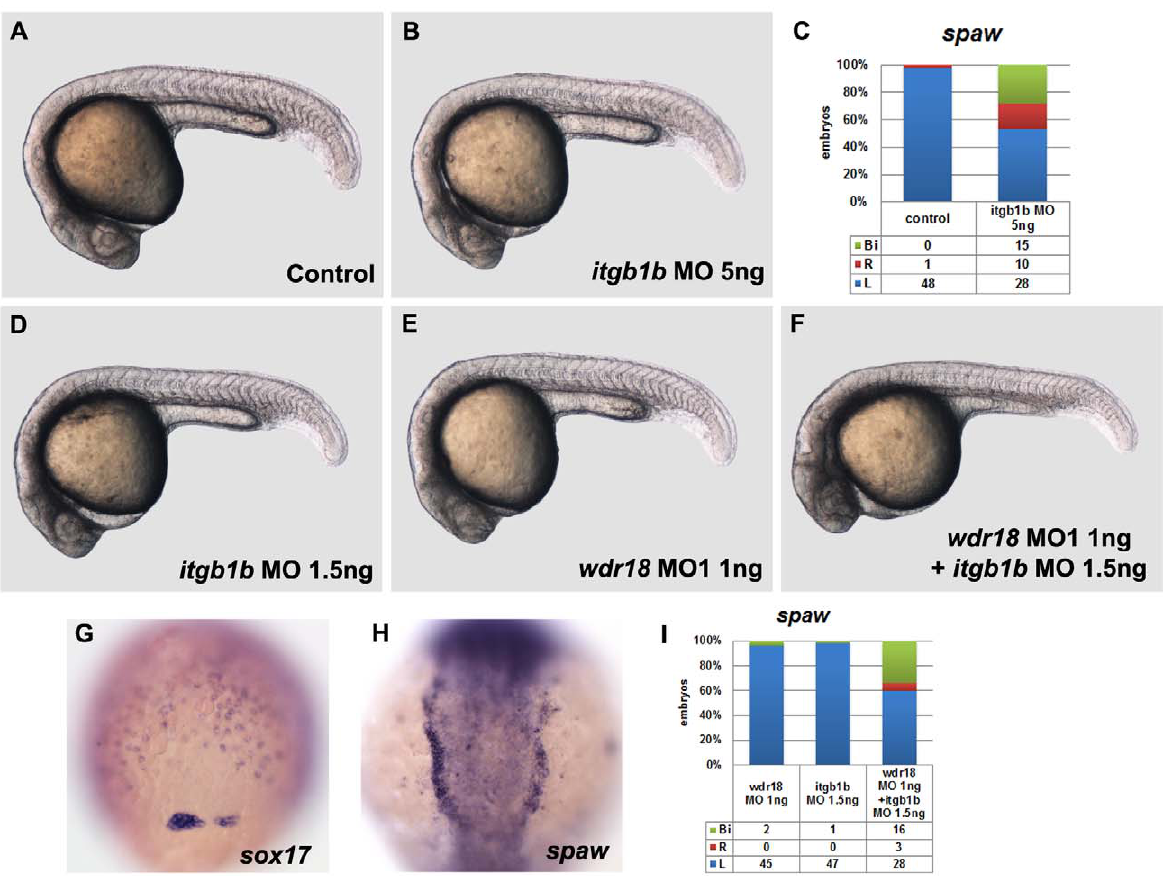
Figure 7. wdr18 and integrin b 1b act genetically in the regulation of laterality development. (A) A control embryo under a light microscope. (B) The overall morphology of embryos injected with 5 ng of itgb1b morpholino is indistinguishable from controls. (C) The percentage of control and itgb1b morphant embryos with left-sided (L), right-sided (R), or bilateral (Bi) spaw expression. (D, E, F) The morphology of embryos injected with 1.5 ng itgb1b morpholino (D) or 1 ng wdr18 MO1 (E), and embryos injected with a combination of 1 ng wdr18 MO1 and 1.5 ng itgb1b morpholino (F) look relatively normal, except for a minor difference in body curvature (F). (G) sox17 staining in embryos injected with a combination of 1 ng wdr18 MO1 and 1.5 ng itgb1b morpholino indicates that DFC migration is affected. Dorsal view, animal pole to the top. (H) An example of bilateral spaw expression in the LPM of embryos injected with a combination of 1 ng wdr18 MO1 and 1.5 ng itgb1b morpholino. Dorsal view, anterior to the top. (I) The percentage of control embryos injected with 1.5 ng itgb1b morpholino, 1ng wdr18 MO1, or a combination of 1 ng wdr18 MO1 and 1.5 ng itgb1b morpholino showing left-sided (L), right-sided (R), or bilateral (Bi) spaw expression.